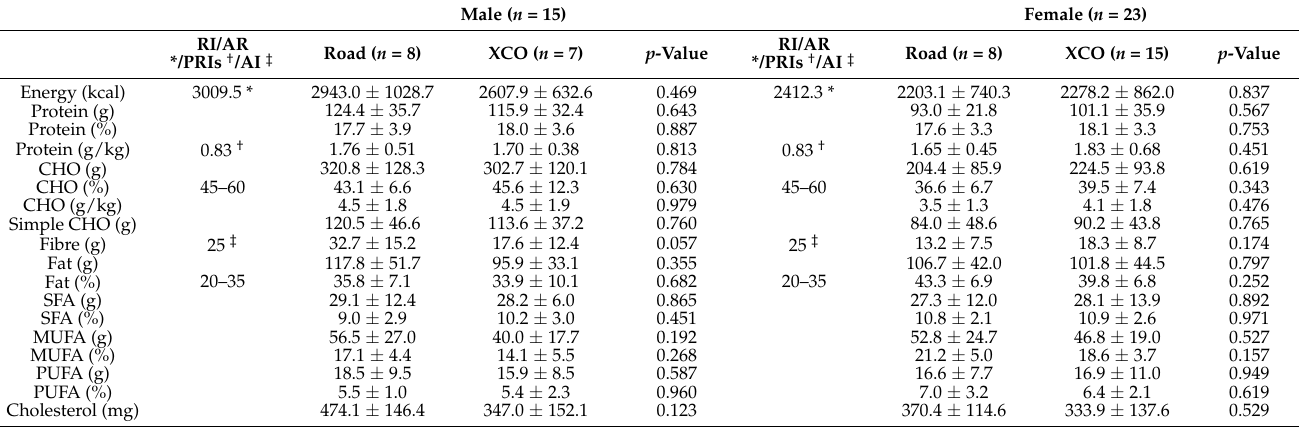
Table 2. Average daily energy and macronutrients intake of cyclists during pre-season.